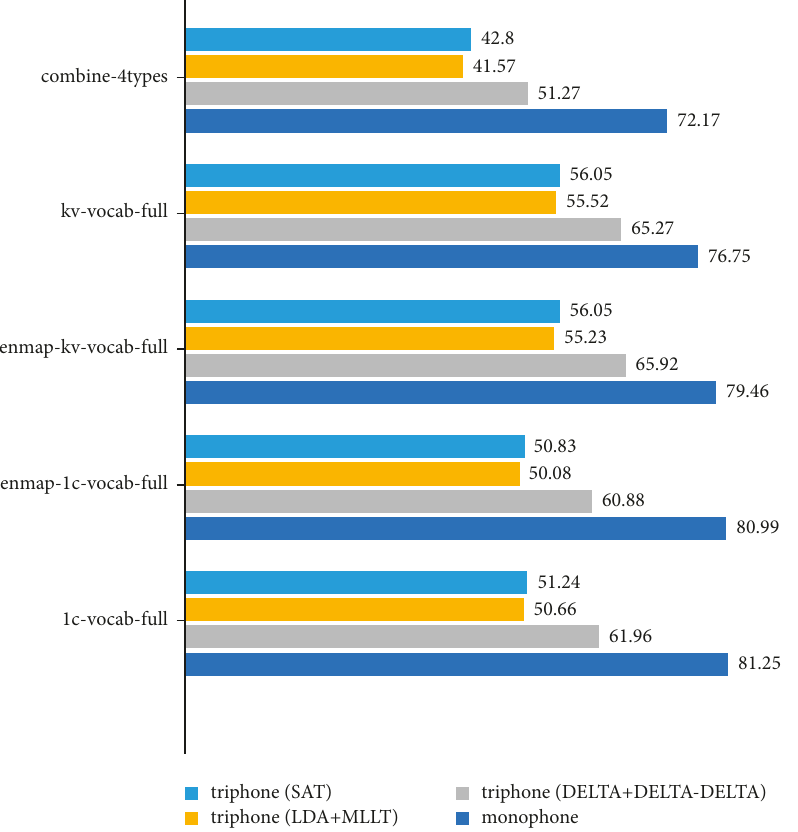
Figure 12: The %WER comparison for different lexicon types on the GMM-HMM models. Table 15: The performance of the models using 46,550 validated augmented vs. nonaugmented utterances. Data